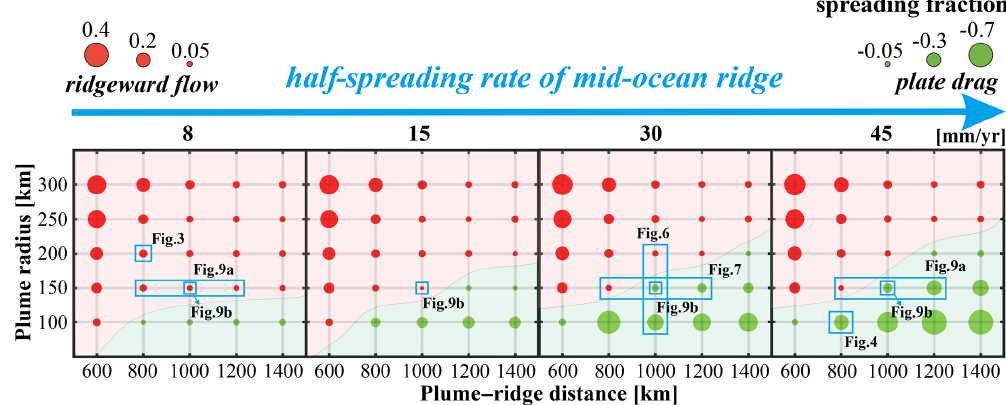
Figure 8. Parameter regime diagram of the contrasting modes of plume–ridge interaction. Spreading fractions γ (Eq. 14) at an ∼ 8Myr model time. Each of the circles represents one of the numerical experiments, and sizes refer to γ . Circles in red and green represent models with dominant ridgeward plume flow and plate drag, respectively.